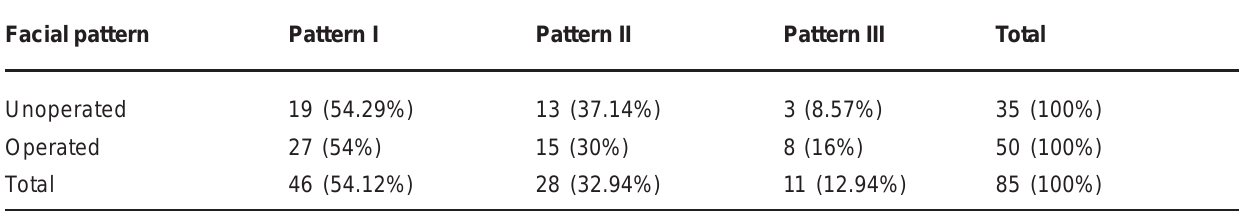
x 2 = 1.20; p = 0.550 non significant.